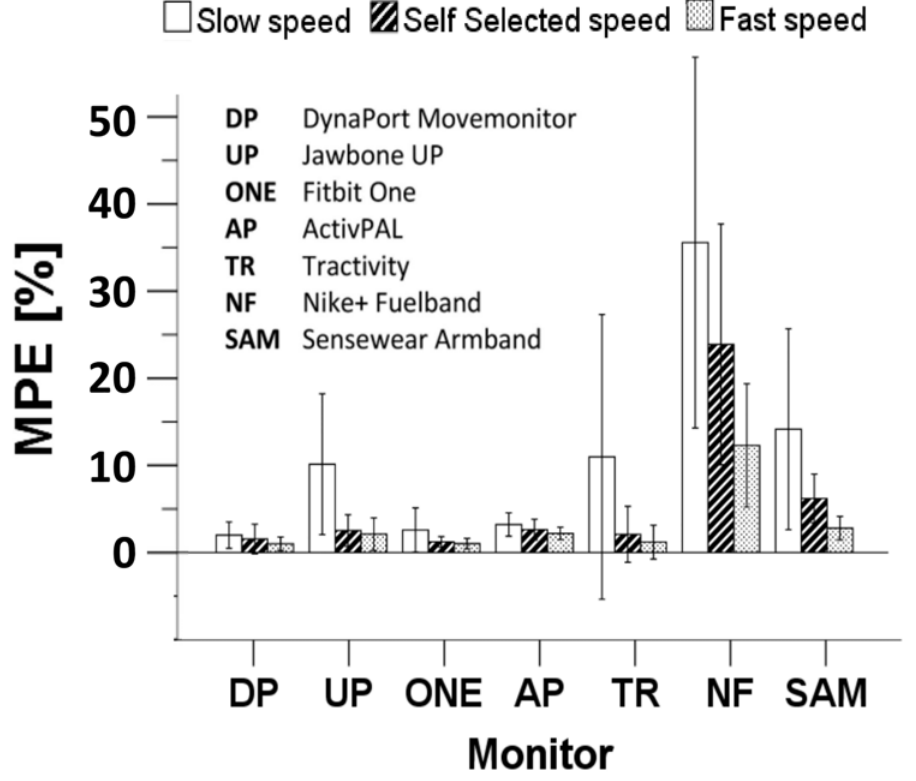
Fig 3. Summary of MPE for the 7 PAMs included in the study. The figure shows the mean percentage error (MPE) during slow, self-selected and fast walking speed trials for all the sensors included in the study. Error bars are mean ±